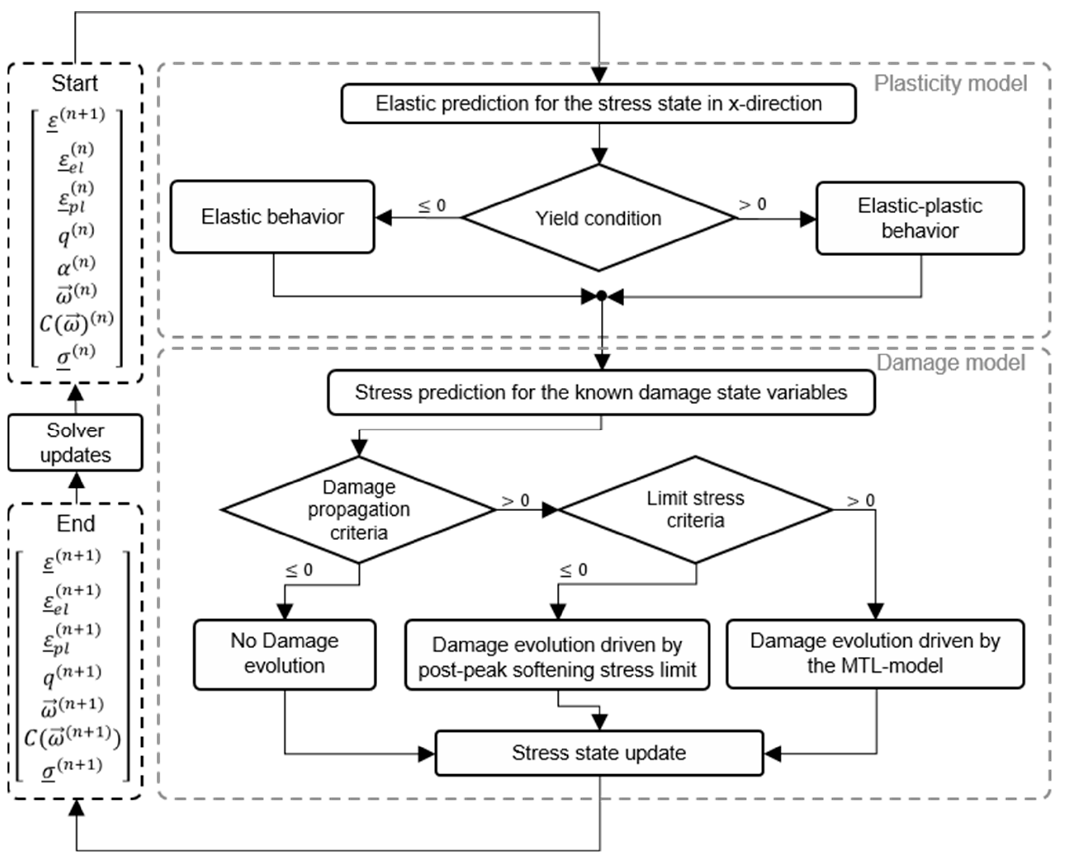
Figure 1. Flowchart of the sequential treatment of the plasticity and the damage model within the implemented material model.